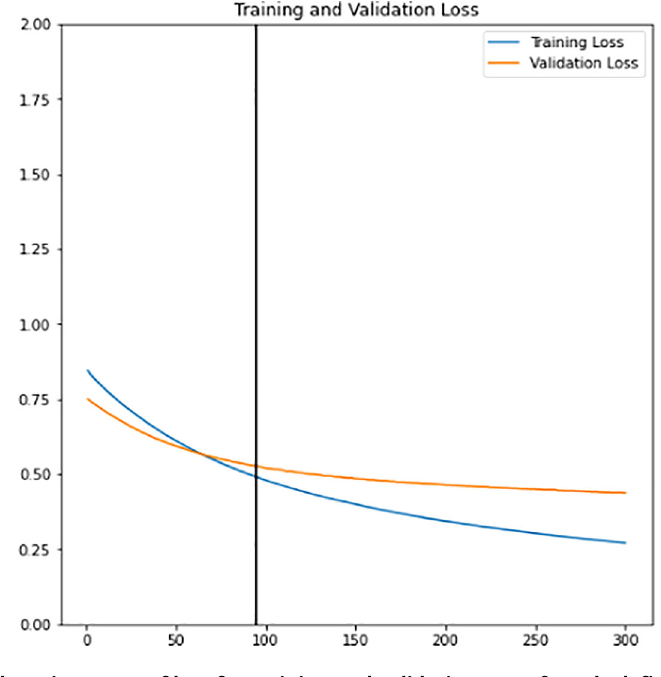
Figure 10. Training learning curve of loss for training and validation sets of newly defined classifier.